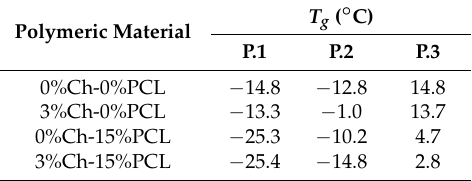
Table 1. DSC thermograms of the synthesized PUs depending on the polyol used.